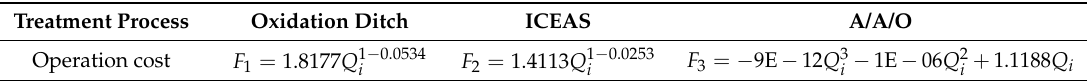
Table 6. Operation costs of three types of sewage treatment process (lv 2009